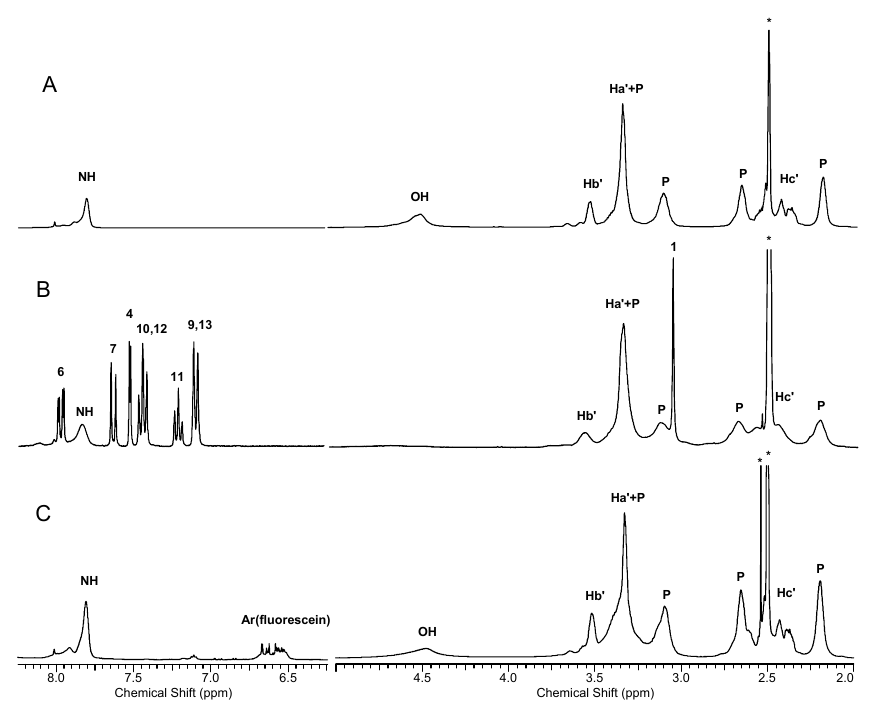
Figure 3. The relevant fragments of 1 H NMR spectra of: A — G3 gl , B — G3 G02N , C — G3 G0F in DMSO-d 6 . Intensity of resonances in the left trace B was multiplied by factor of 2. The resonances of nimesulide aromatic protons are labeled according to numbering shown in Scheme 3. The resonances from PAMAM G3 and PAMAM G0 cores are labeled P, while signals from 1,2-dihydroxypropyl substituents are labeled according to Scheme 2. Residual solvent and impurity resonances are labeled with asterisks.